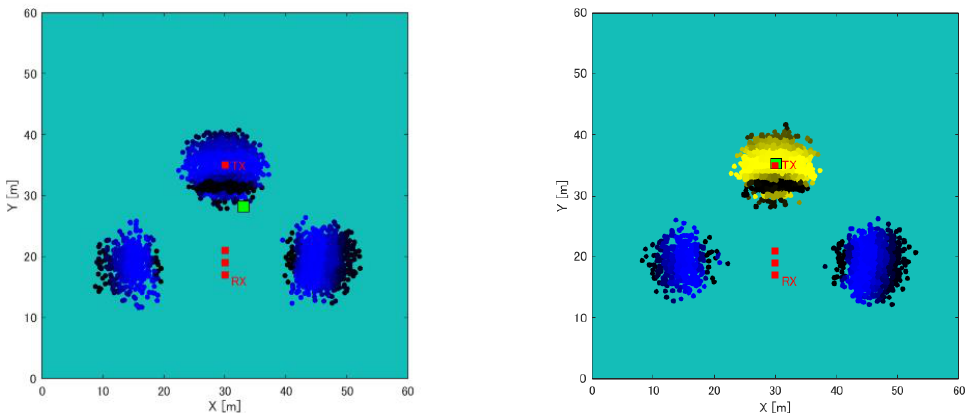
Figure 5. Distribution of the particles in wildness. The difference in distribution, depending on the number of steps. The green dot represents the estimated position of Tx.